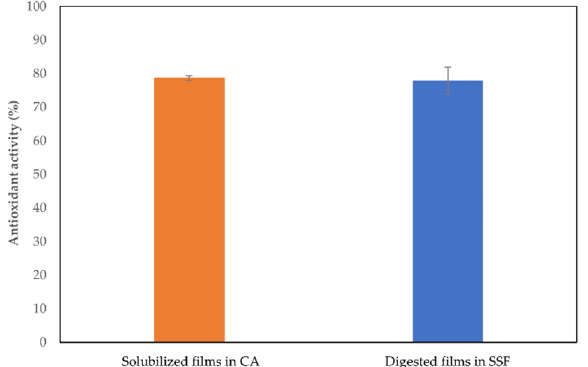
Figure 4. Antioxidant activity by DPPH assay of 20% ( v / v ) DOLE films subjected to in vitro oral digestion after 30 days compared to the AA of solubilized films after 30 days.